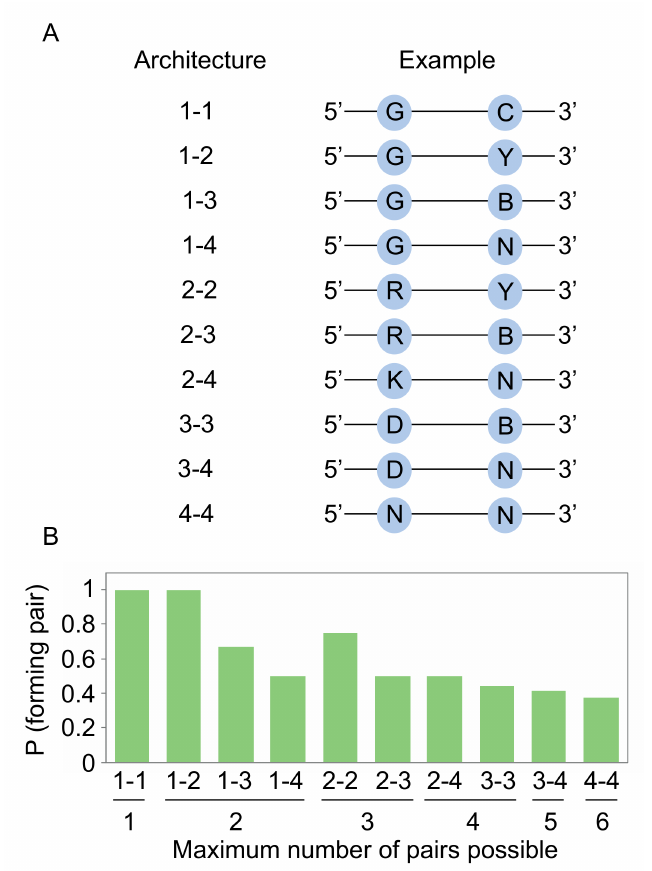
Figure 2. Encoding base pairs with degenerate positions. ( A ) The ten possible architectures for encoding base pairs by solid-phase synthesis. The number of possible nucleotides at each position in the base pair in each architecture is shown on the left, and an example is shown on the right. ( B ) Tradeoff between the number of possible pairs that can be encoded in each of the ten architectures ( x axis) and the maximum probability of forming a pair in the architecture ( y axis). Y = C or U; R = A or G; K = G or U; B = C, G, or U; D = A, G, or U; N = A, C, G, or